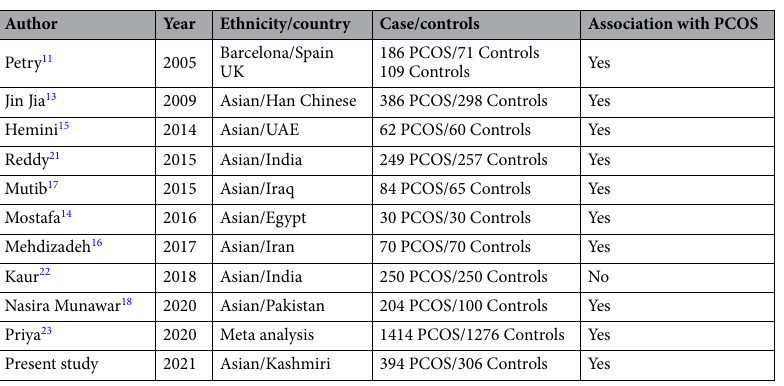
Table 6. Comparison of the present study with previous studies of SNP rs2414096 polymorphism of CYP19 gene and Polycystic ovary